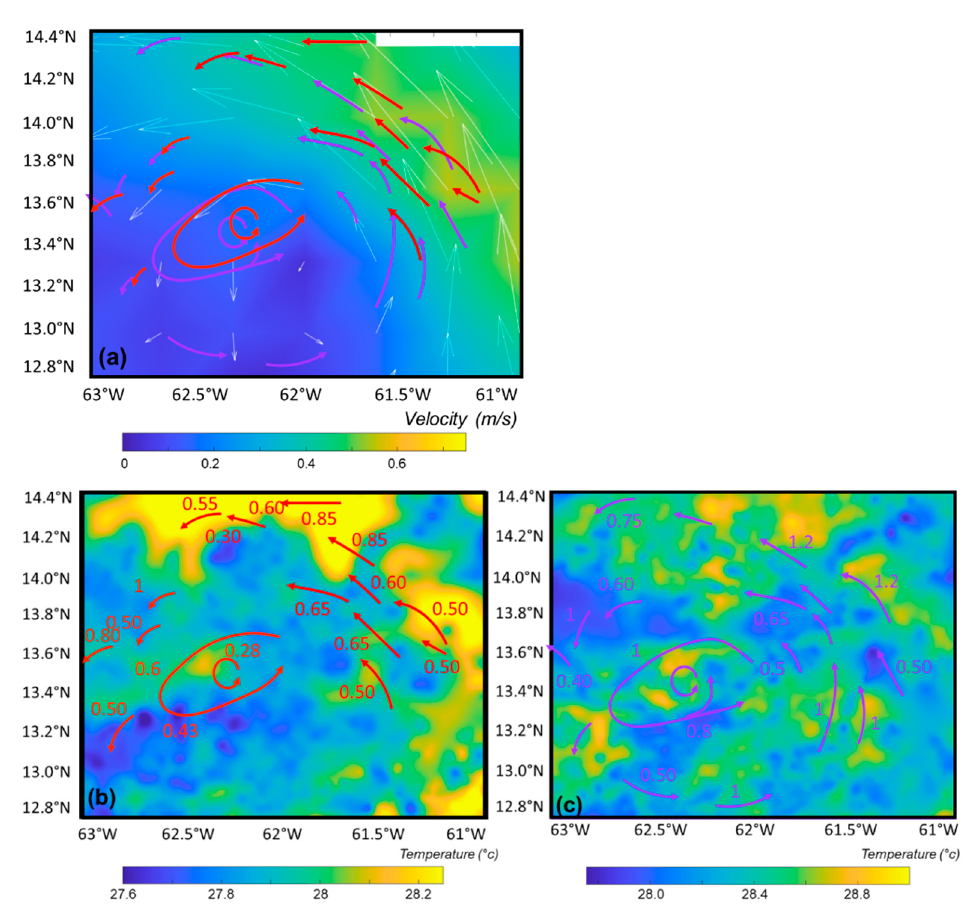
Figure 11. ( a ) Modeled Oscar Third Degree Sea Surface Velocity, ( b ) GHRSST (Group for High Resolution Sea Surface Temperature) of the water mass on 8 August 2018, and ( c ) GHRSST temperature of the water mass on 9 August 2018.